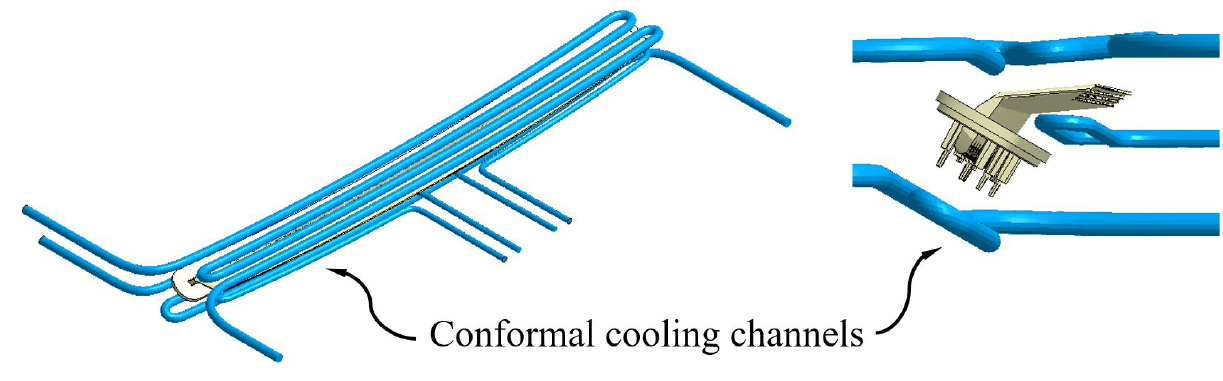
Figure 8. Hybrid cooling system design, Fastcool full bars. Figure 7. Conformal cooling channels design. Figure 7. Conformal cooling channels design.